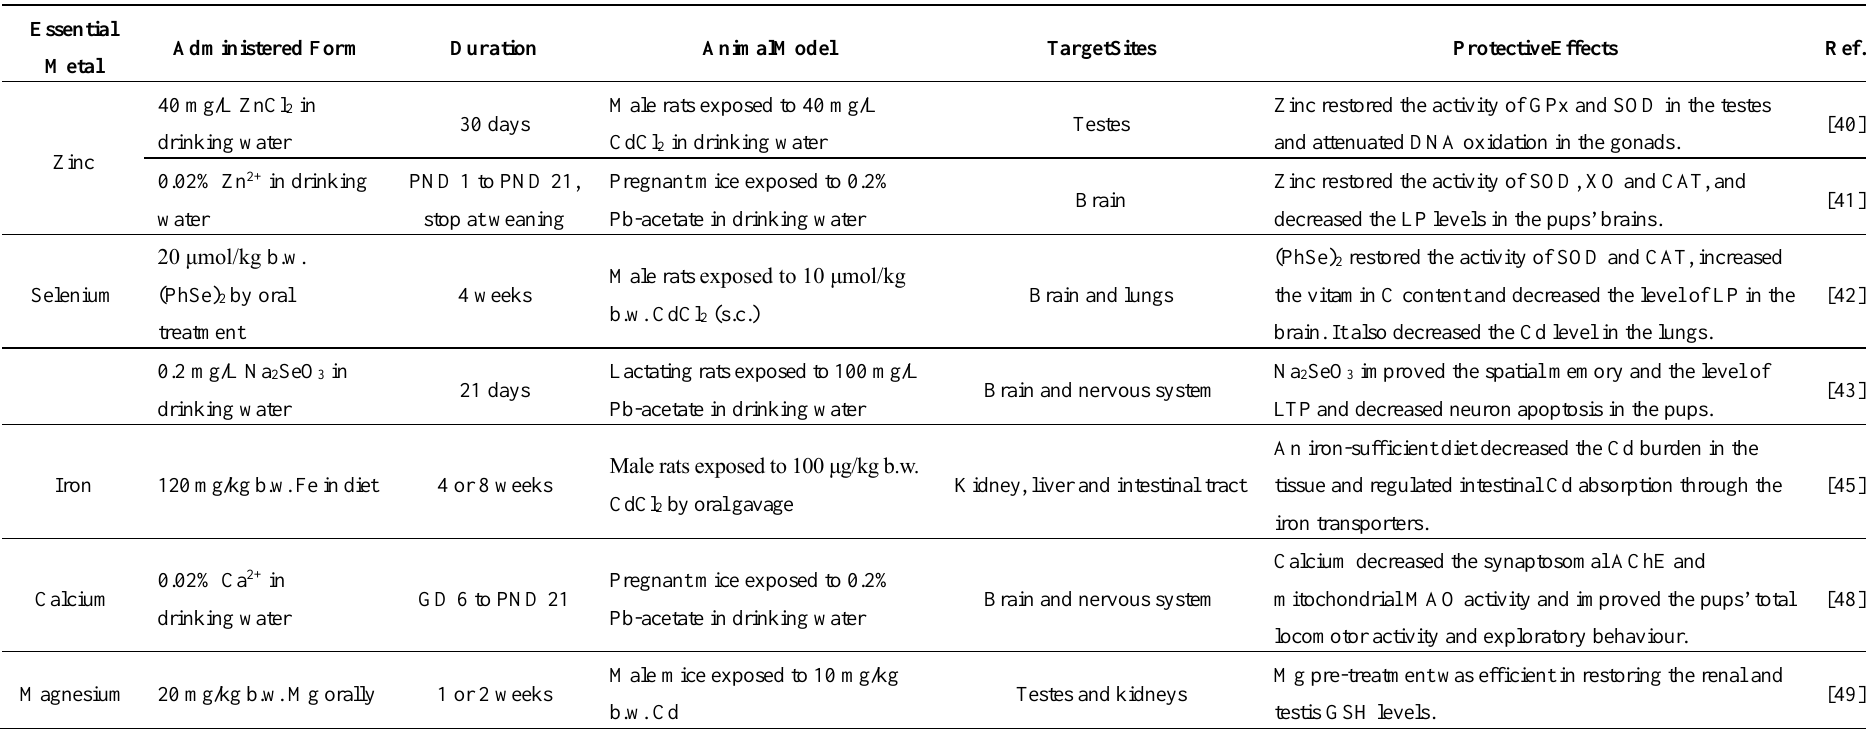
Table 1. Selected studies on the protective effects of essential metals against Cd and Pb